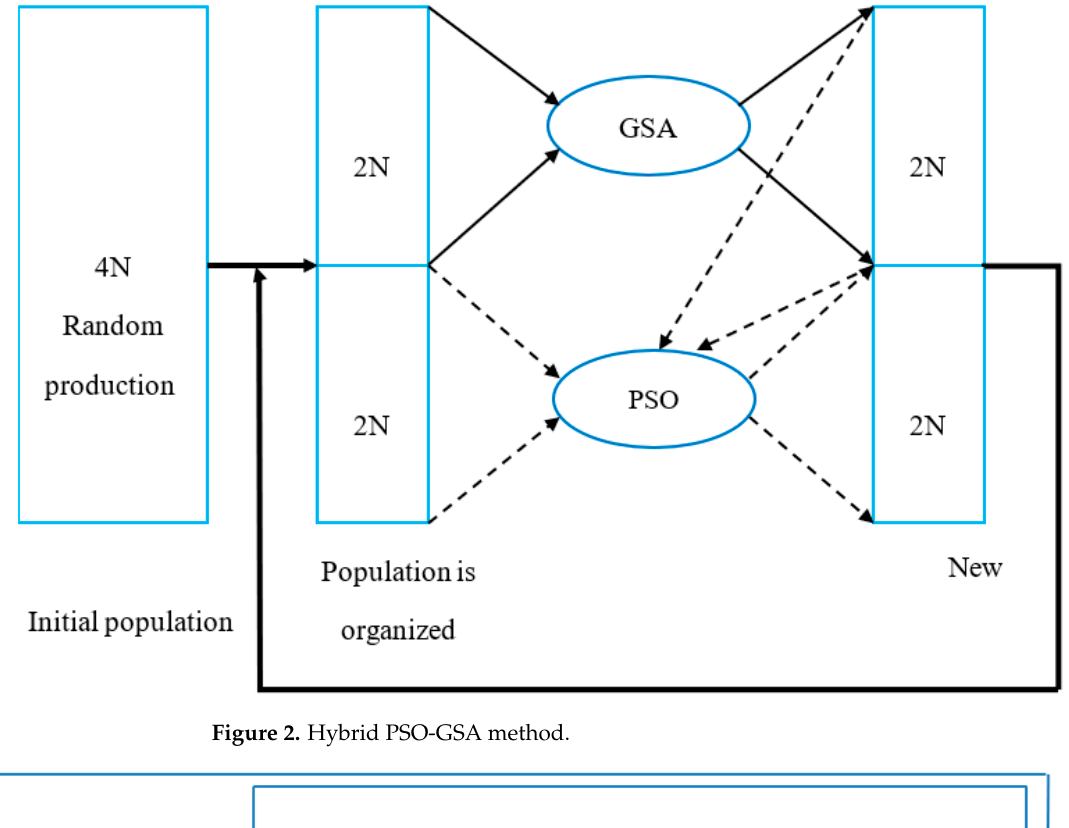
Figure 2. Hybrid PSO-GSA method.